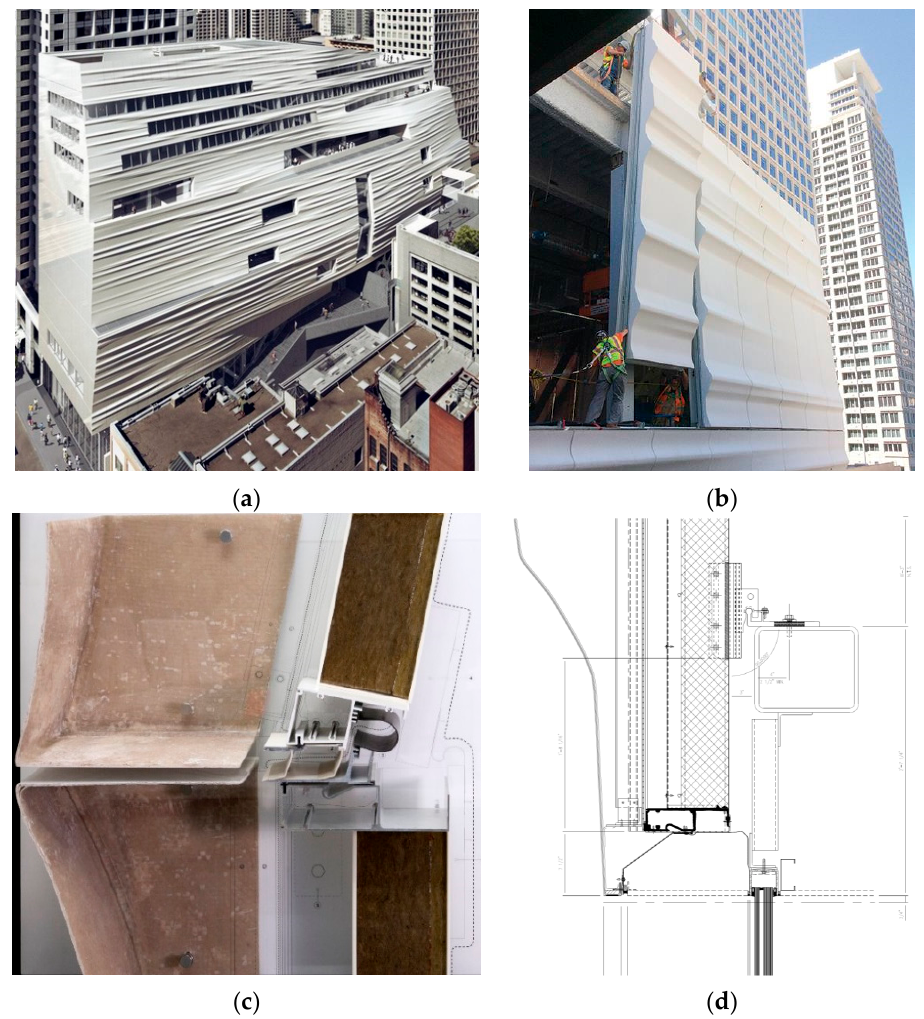
Figure 4. East facade ( a ), photo of the mounting phase ( b ), and detail ( c and d ) of the fiber reinforced polymer (FRP) panels of the expansion to the San Francisco Museum of Modern Art, opening in 2016. Table 1. Main characteristic values for FRPs and other traditional building materials. FRPs data have been elaborated from [1,6,7].